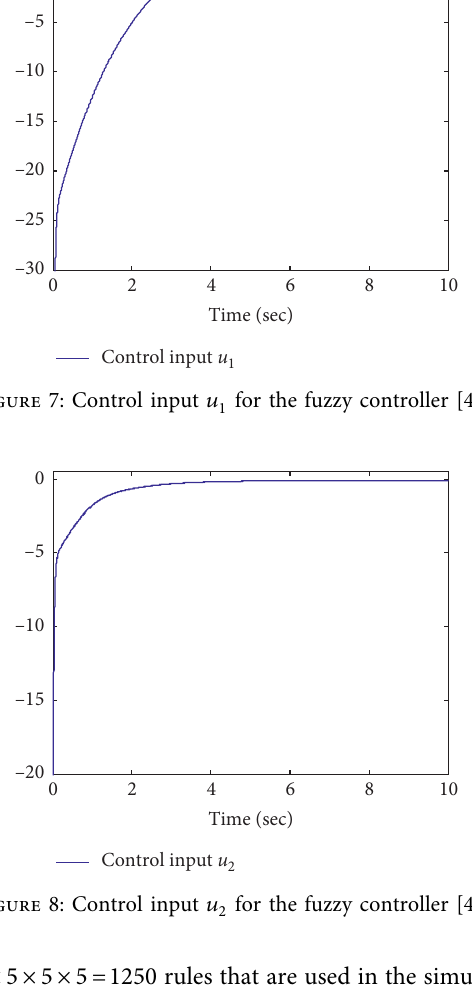
for the fuzzy controller 2